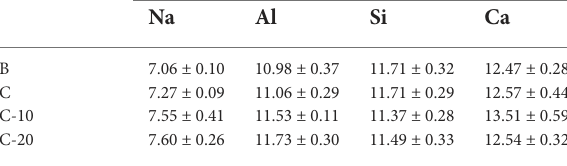
TABLE 4 Leachability